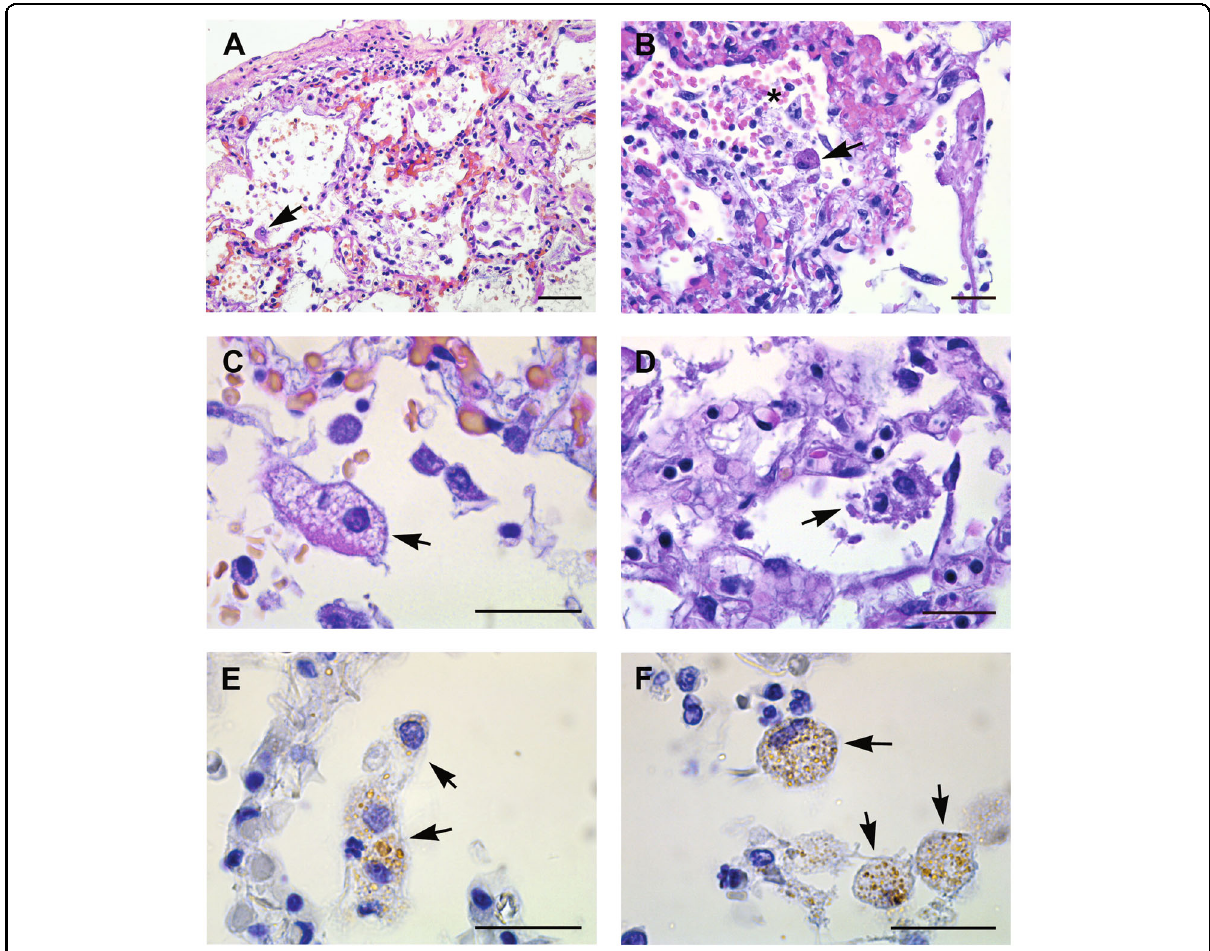
Fig. 5 Histopathological changes of lung tissue from COVID-19 patients. A , B EE staining from lung tissue shows diffuse alveolar damage, with intra-alveolar in fl ammation, fi brin, and hyaline membranes. Hyperplasia of type II pneumocyte, characterized by amphophilic cytoplasm, large nuclei, and prominent nucleoli is visible (arrows). Necrotic cells are present in the alveolar space (asterisk) ( B ). C Type II pneumocyte showing signs of degeneration characterized by large nucleus, with fi ne and uniformly dispersed chromatin and cytoplasm vacuolization (arrow). D Degenerating pneumocytes showing tipical features of pyroptosis (arrow). E , F Immunohistochemistry anti-coronavirus revealed a focal distribution of the positivity (arrows). Scale bars: A = 14 μ m; B – F = 7 μ